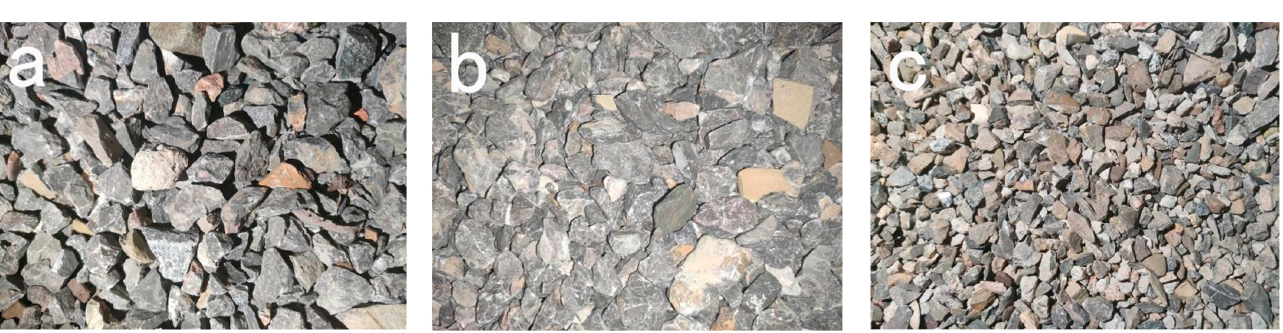
Figure 8. Three kinds of RA with different qualities ; ( a ) SC-RA; ( b ) OP-RA; ( c ) DP-RA.